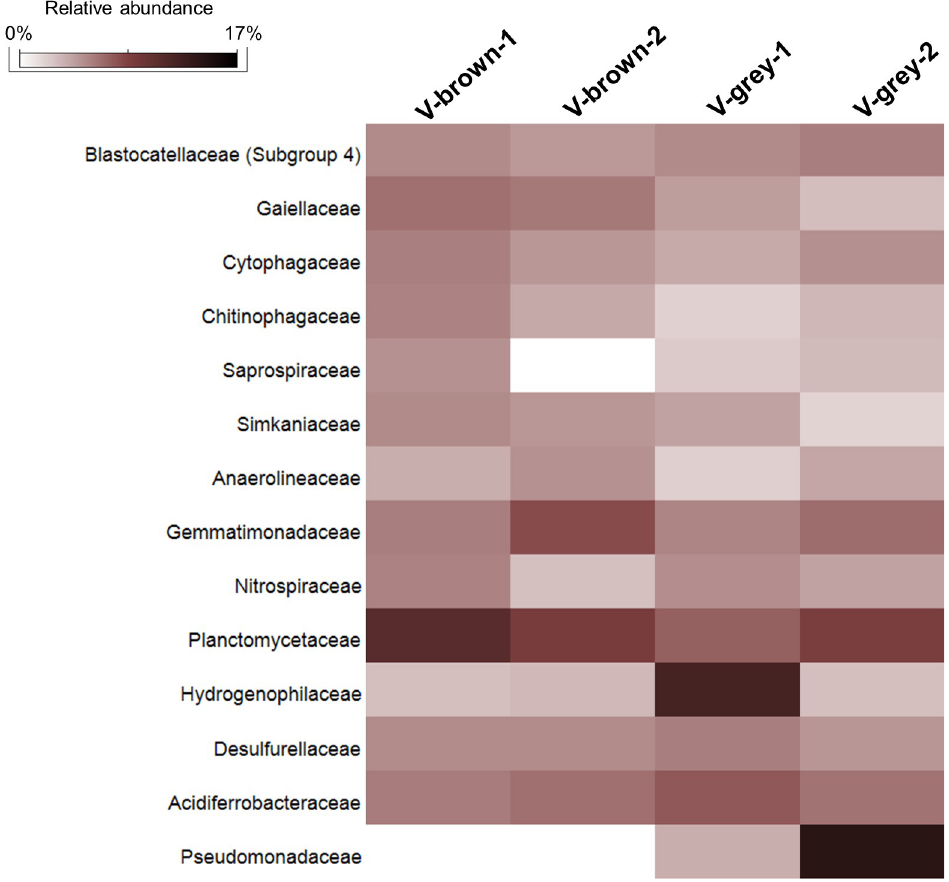
Fig 10. Heatmap showing the abundance of the microbial families present in Fetida Cave vermiculations. Only those families with a relative abundance > 2% are